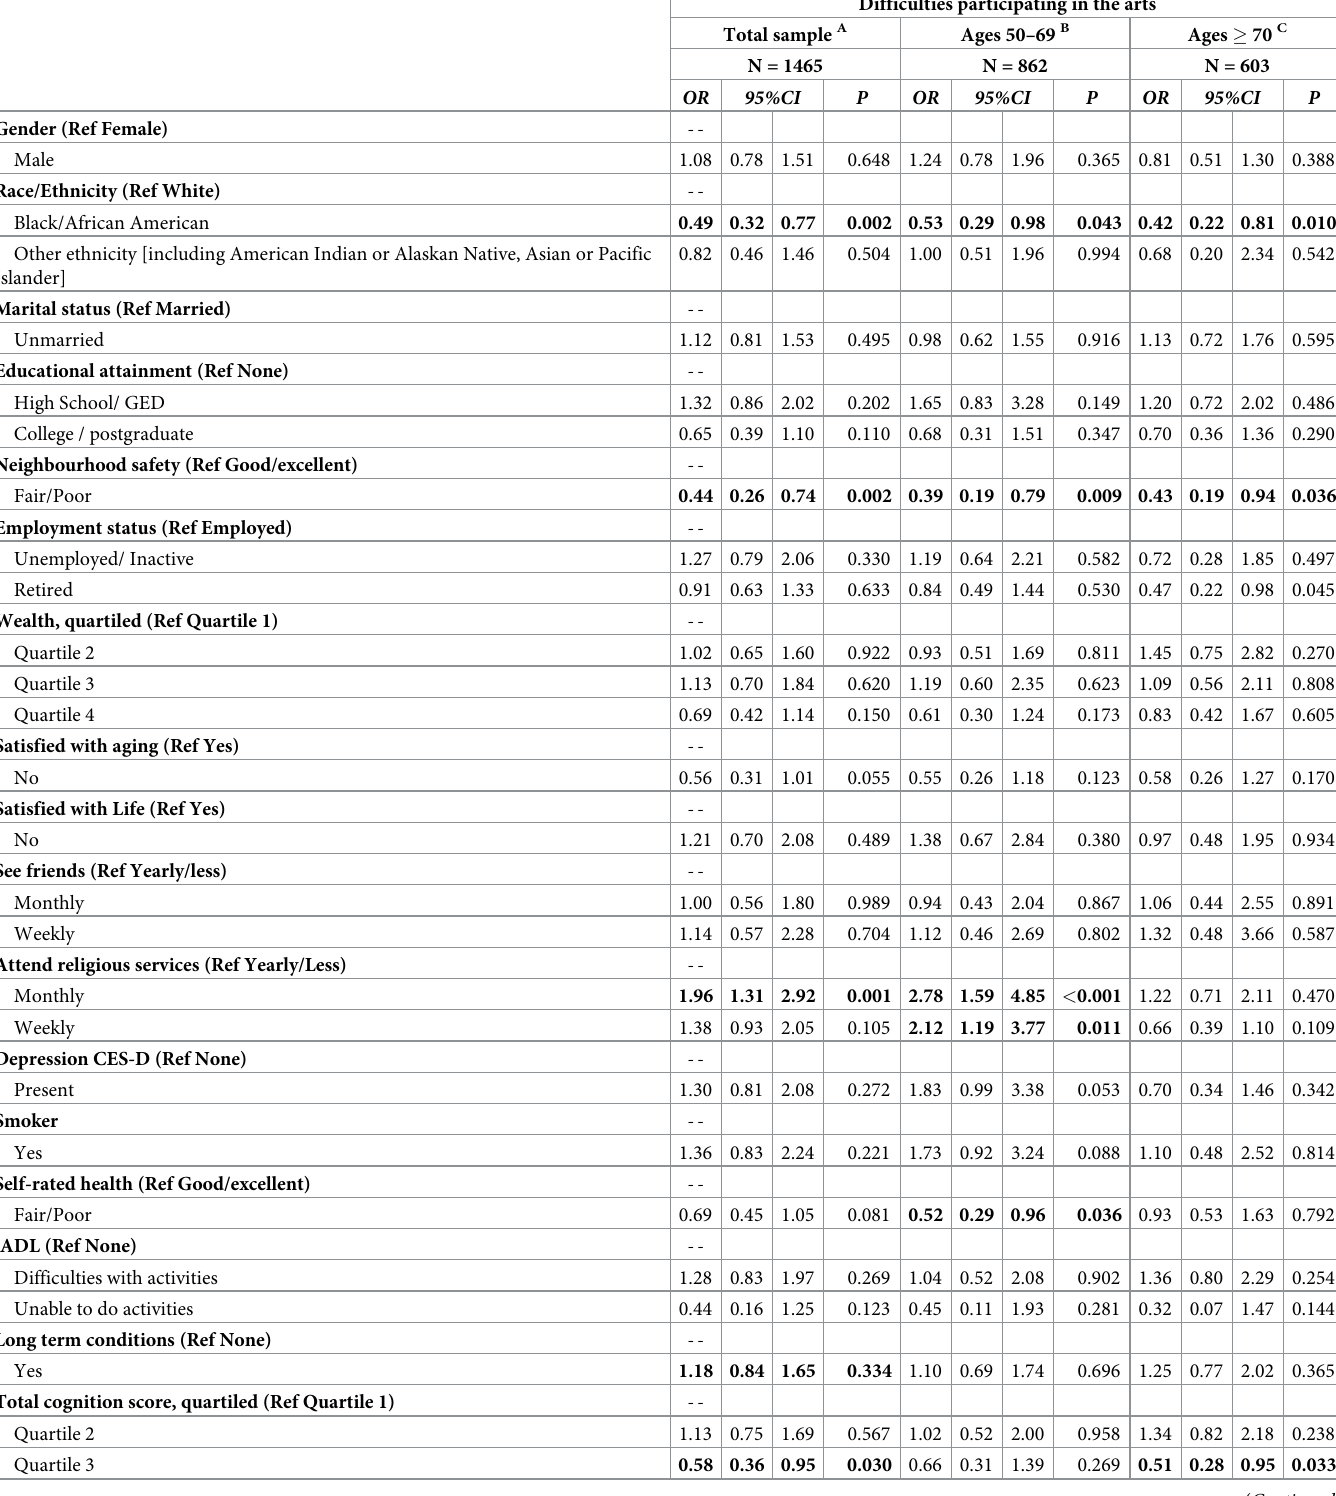
Table 3. Age related differences in reported difficulties participating in the arts in the past 12 months from logistic regression